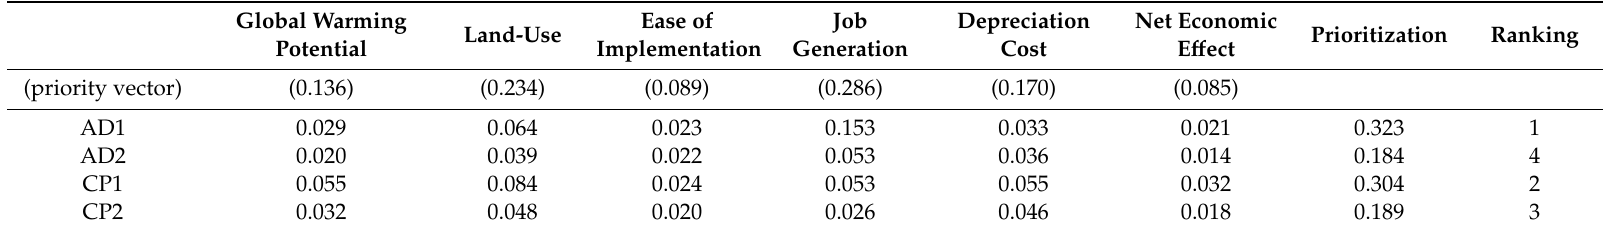
Table 9. Evaluation and ranking of the FW-to-energy alternatives under